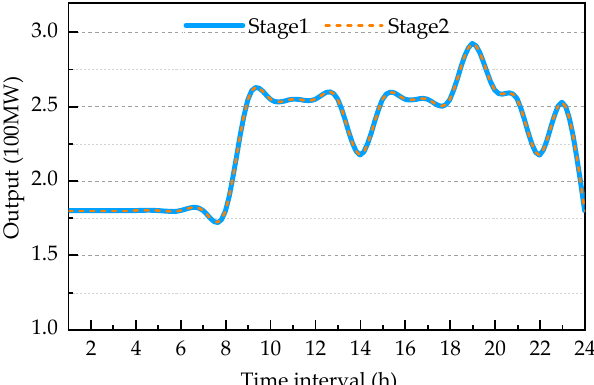
Figure 8. Comparison of outputs of the coal-fired unit with capacity of 350 MW.